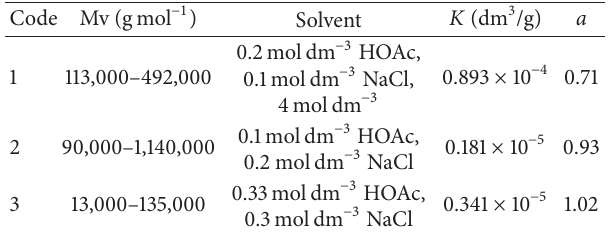
Table 2: Viscosity parameters of chitosans (for references and discussion, see Roberts